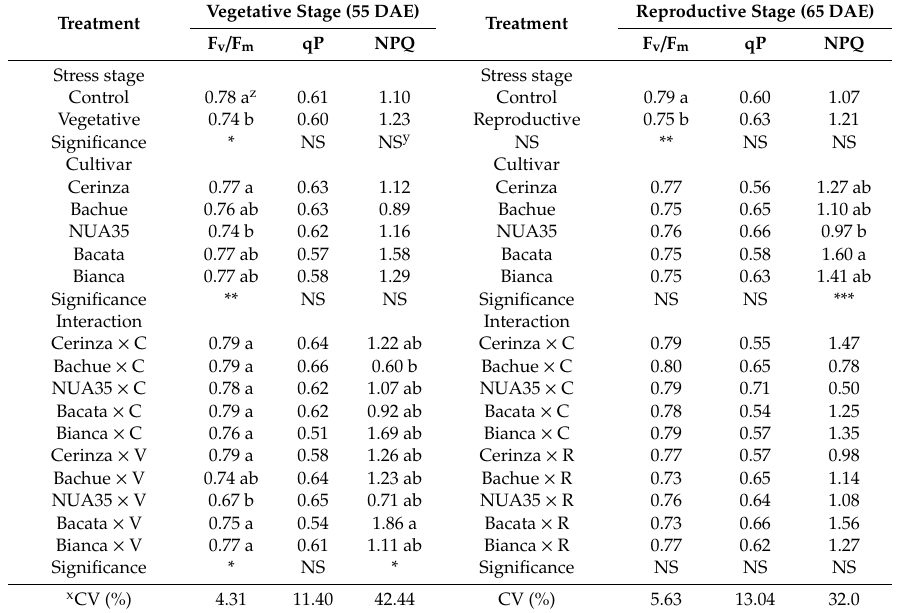
Table 2. Effect of water deficit stress in two different phenological stages on fluorescence parameters Table 2. E ff ect of water deficit stress in two di ff erent phenological stages on fluorescence parameters of of five bush bean cultivars (55 DAE and 65 DAE). five bush bean cultivars (55 DAE and 65